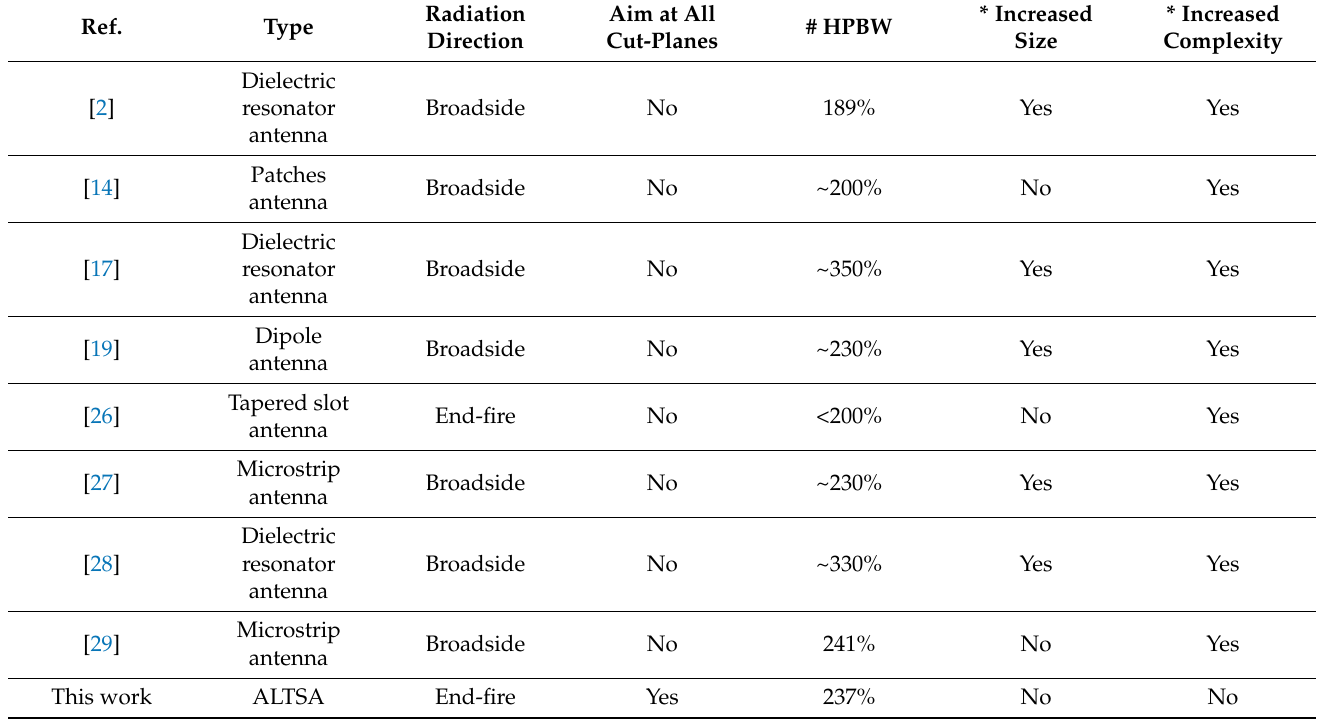
Table 3. Comparison between wide-beam